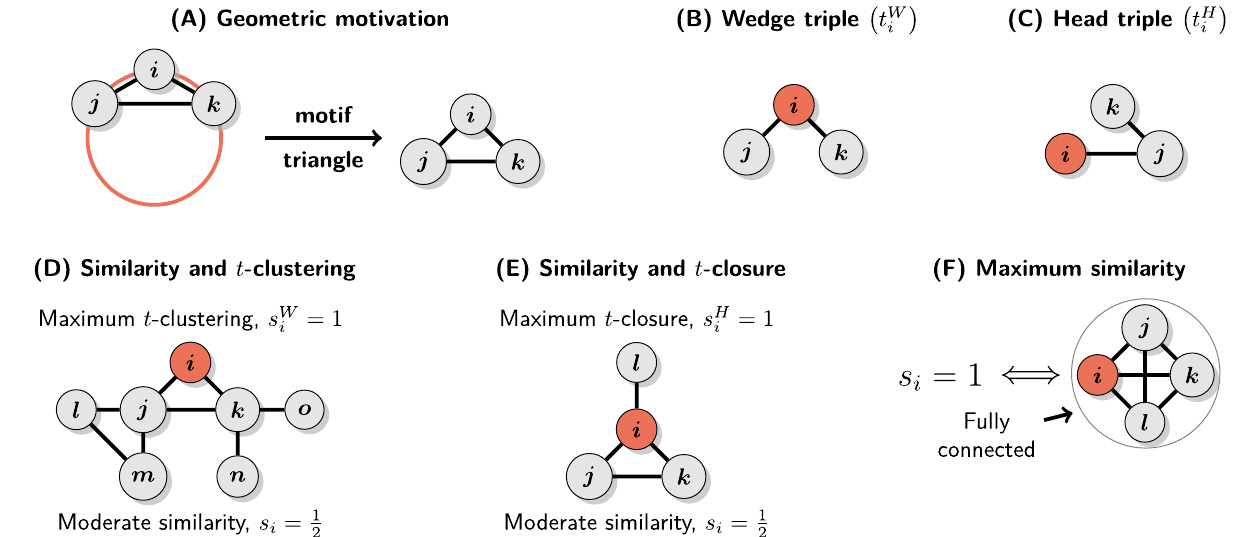
Figure 2. Geometric motivation and the main properties of structural similarity coefficients. ( A ) Metric structure induced by similarity implies transitivity of relations and the abundance of triangles. ( B , C ) Wedge and head triples. ( D ) Local clustering can be maximized even when neighbors of the focal node are very differently embedded within the network, while s i is sensitive to this kind of non-transitivity. ( E ) Local closure can be maximized even for nodes with sparse 1-hop neighborhoods if they are star-like as neighbors with degree one do not generate any head triples. On the other hand, s i is sensitive to this violation of transitivity. ( F ) Necessary and sufficient conditions for maximum structural